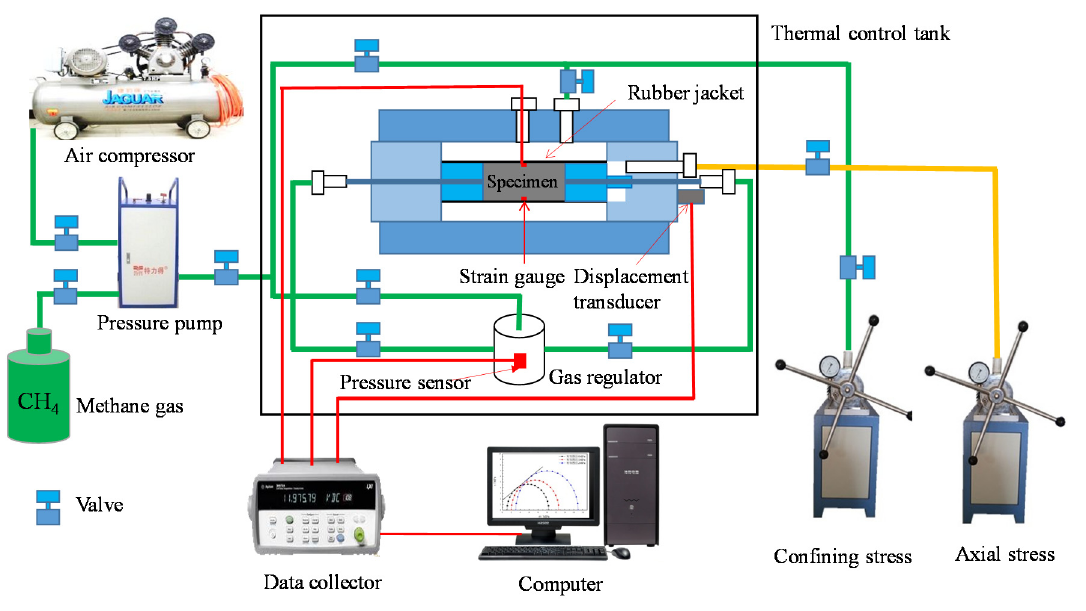
Figure 3. Schematic diagram of apparatus.